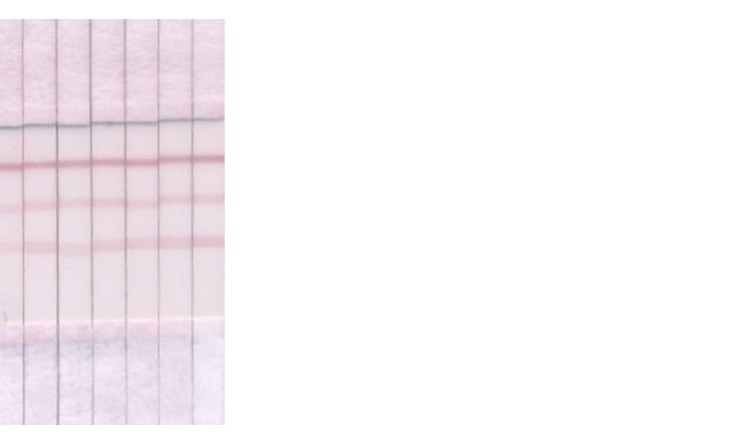
11 of 16 Figure 6. Images of test strips for double ICA in the absence of one of the analytes. The optimization of the test system showed that some of the conditions coincided with those for the individual determination of each phycotoxin (namely, concentrations of immobilized DA–BSA and OA–BSA), and some had to be changed to achieve the max- imum sensitivity of the analysis, taking into account changes in the lineament of the test system. Thus, the volume of the label was increased to 5 μ L, because in the double test there are three label-binding zones, and with an insufficient amount of the label, the col- oration in the T zones is not intense enough to ensure the accuracy and reproducibility of the analysis. However, with this amount of GAMI–AuNPs, the band coloration in the C zone is disproportionately higher than in the T zones (Figure 6), so the DAGI concentra- tion was reduced to 0.1 mg/mL. The amount of antibodies was increased approximately 2 times compared to individual tests (0.2 μ g/mL for anti-OA MAbs and 304 ng/mL for anti-